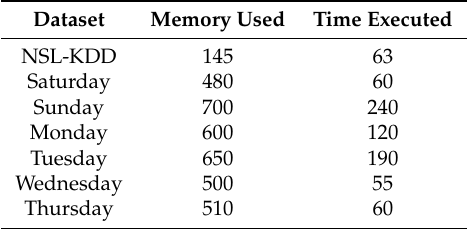
Table 5. The memory profiles of SFSDT model two IDS